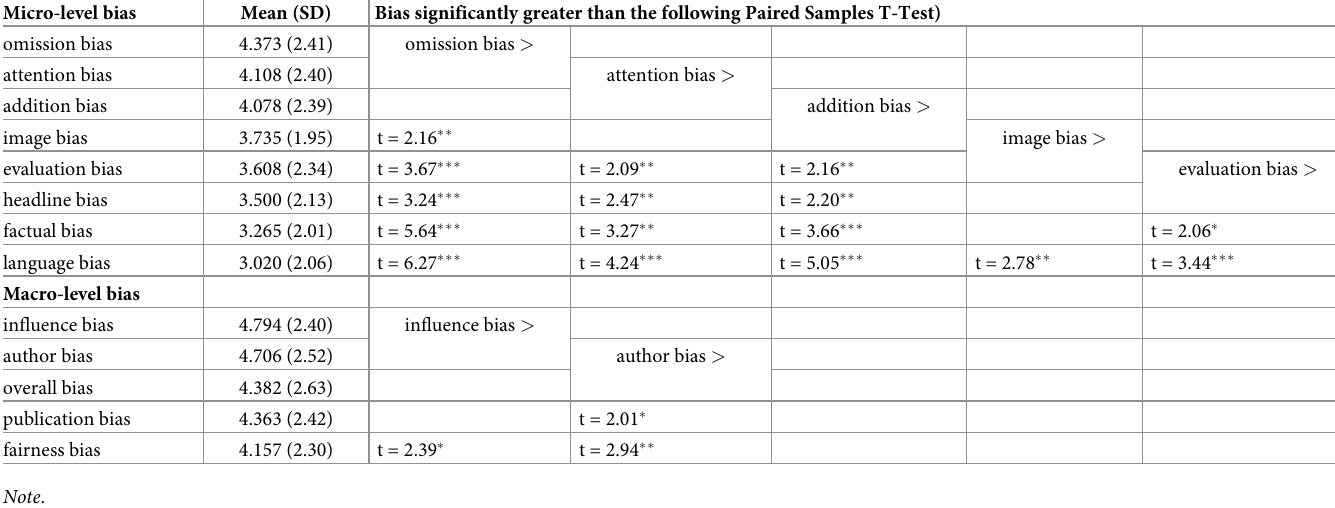
Table 2. Micro and macro-level bias